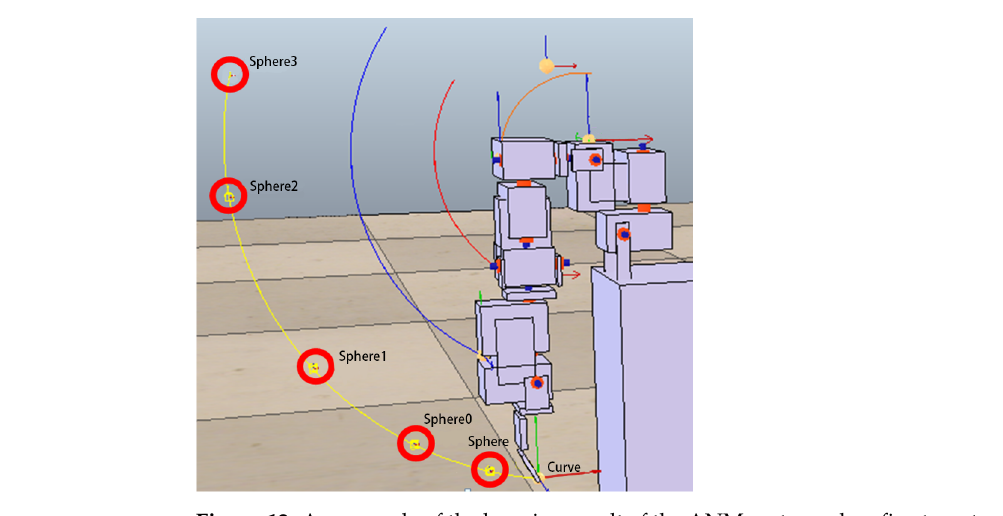
Figure 12. An example of the learning result of the ANM system when five target points are randomly selected from the trajectory of the side-lifting action.